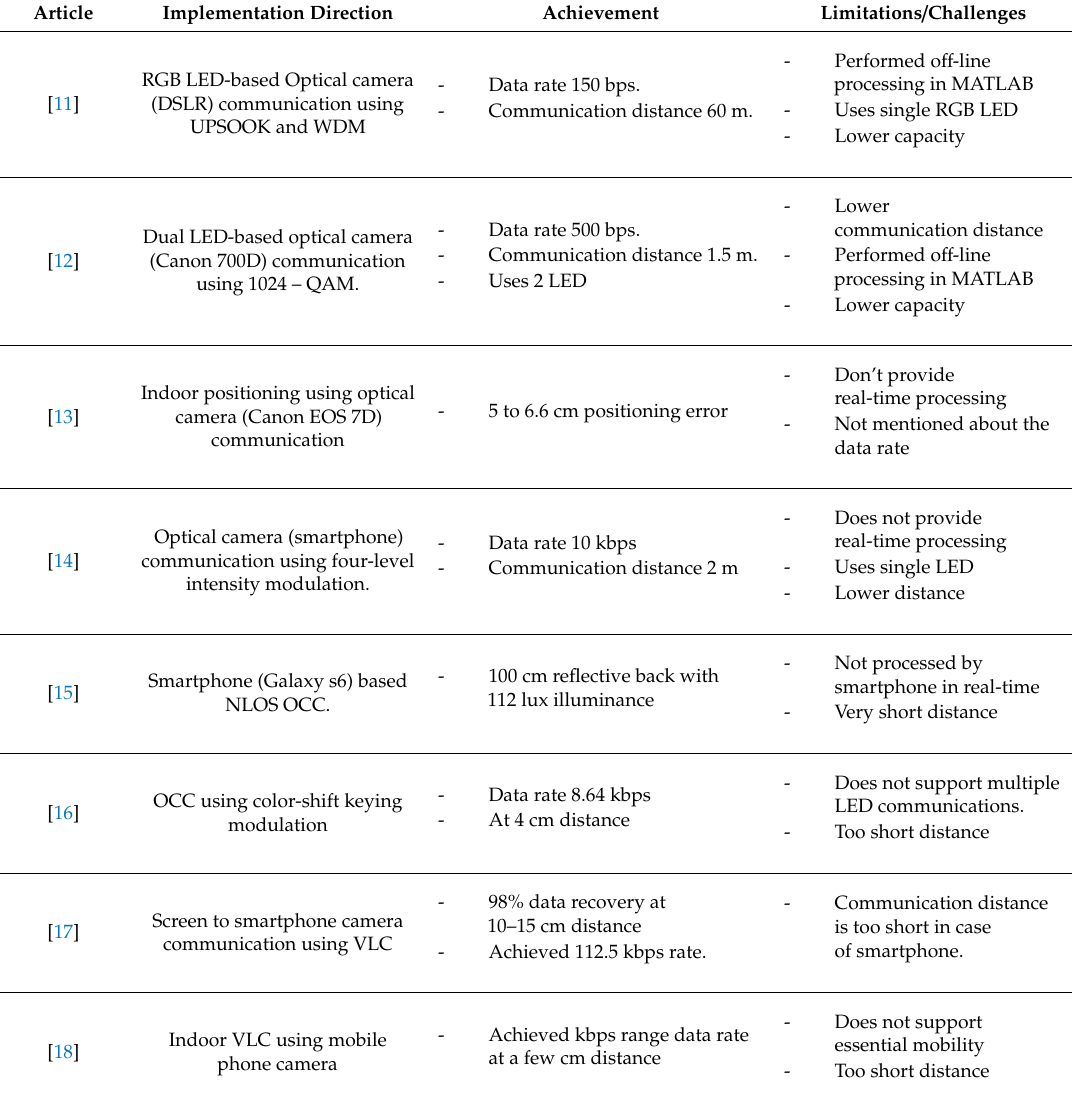
Table 1. Survey of the existing optical camera communication (OCC) implementations with their limitations and